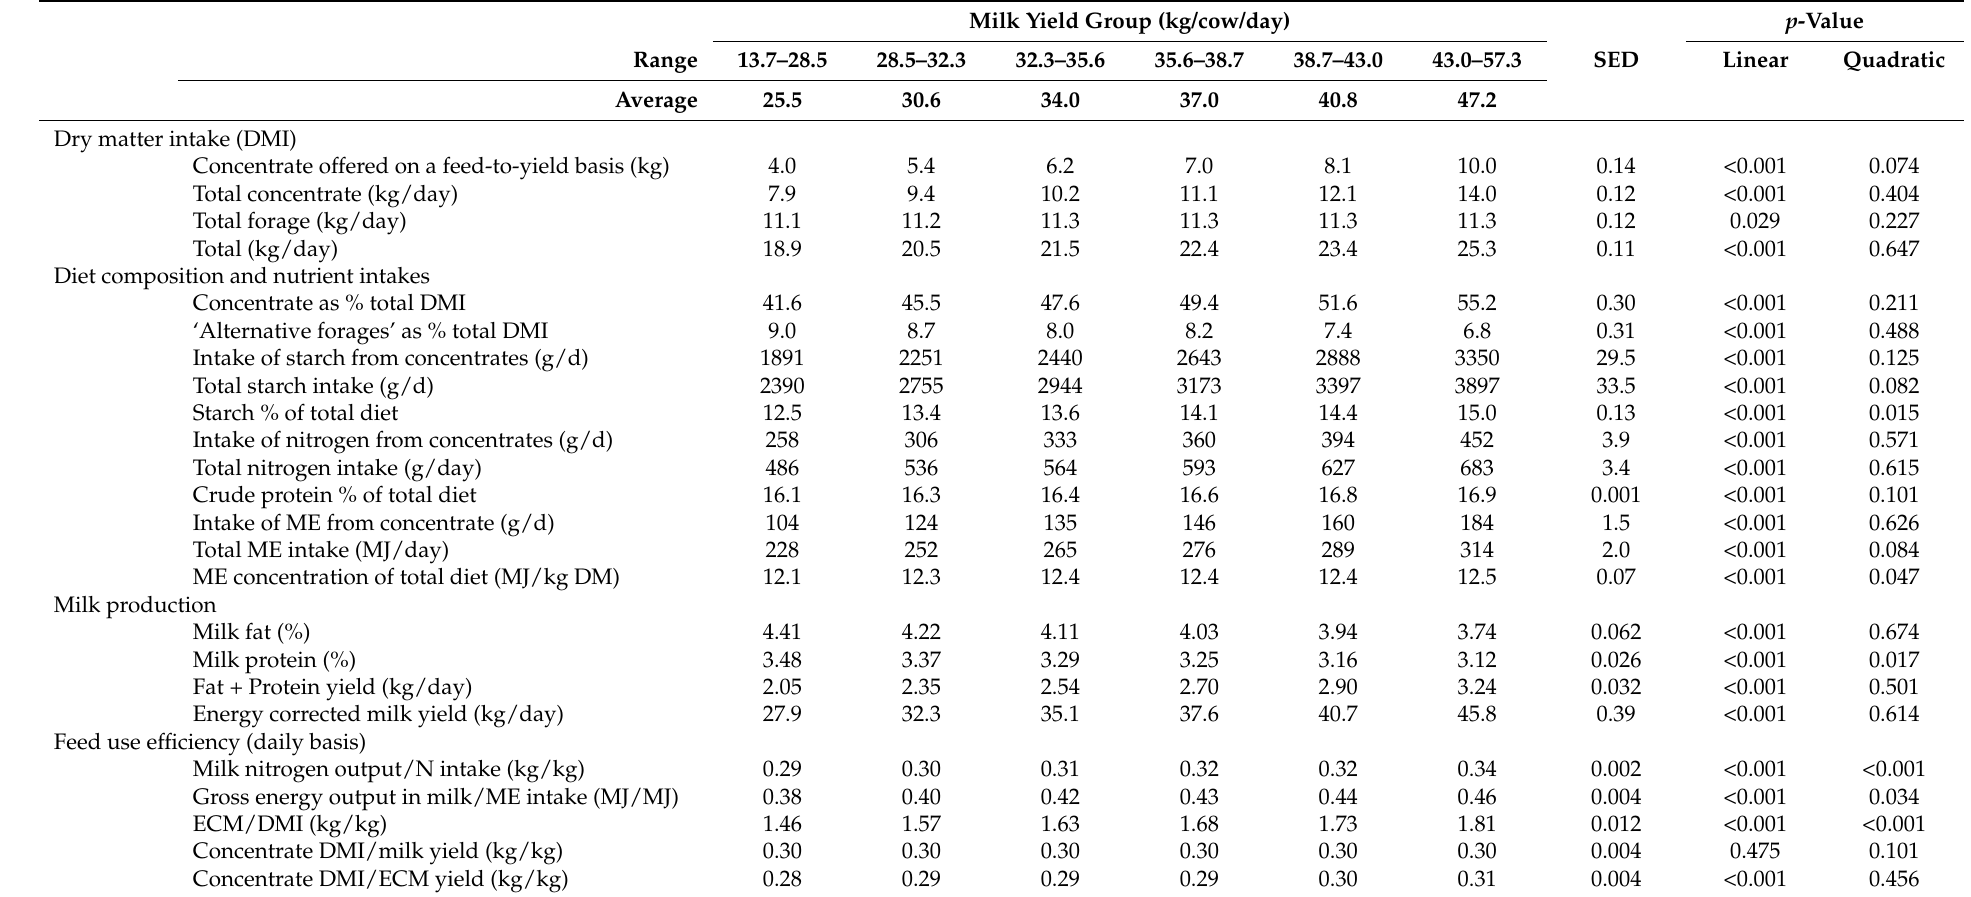
Table 3. Dry matter intakes, nutrient intakes and diet composition, milk production, and efficiency values within each milk yield group for second lactation